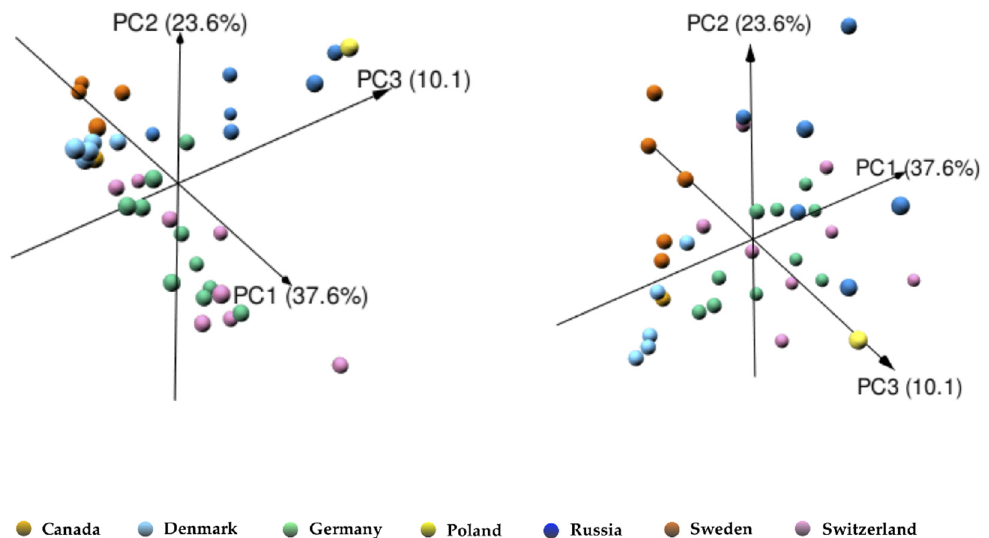
Figure 4. The 3D score plot of principal components PC1, PC2 and PC3 for EOs of PS based on the sesquiterpenes. Each sample is colored based on its origin.